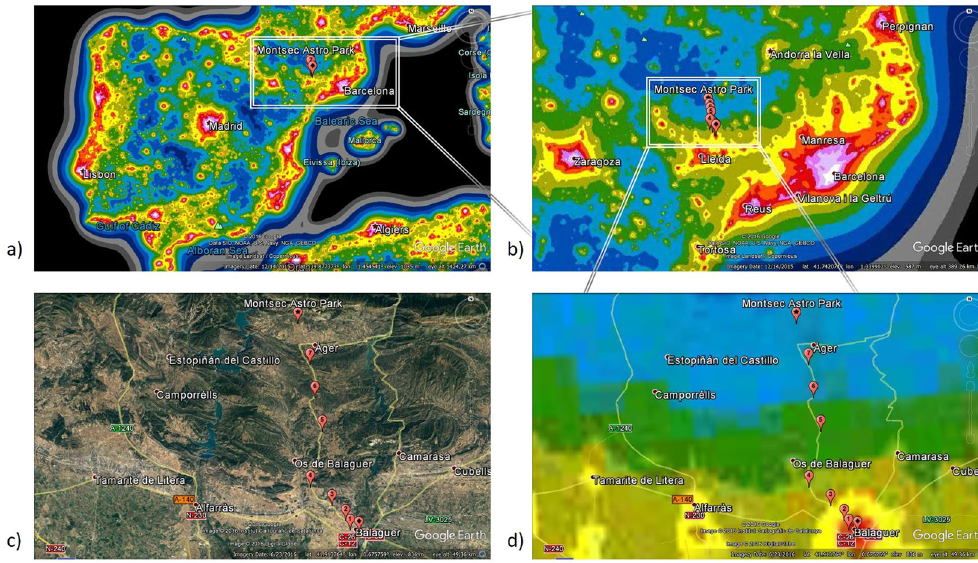
Figure 4. Location of the transect near the Spanish town of Balaguer towards Montsec Astronomical Park: Night skybrightness maps (taken from ref. 30) of ( a ) Spain, ( b ) Catalonia and d ) the local area. ( c ) Shows a map of the local